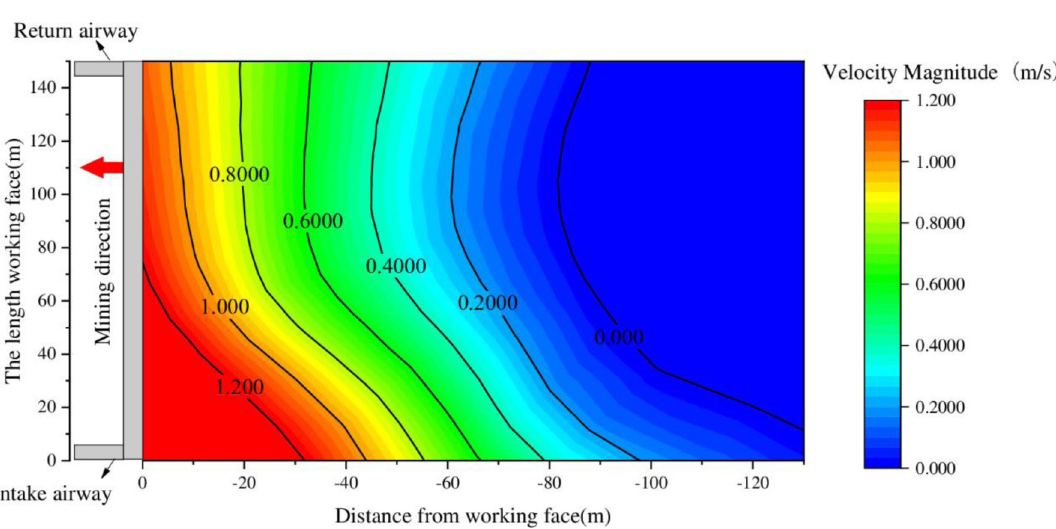
According to the field measured data in Table 1, through the data fitting method, the isoline distribution chart of the air leakage velocity in the surface mining cracks of the 6104 working face is obtained, as shown in Fig 3.